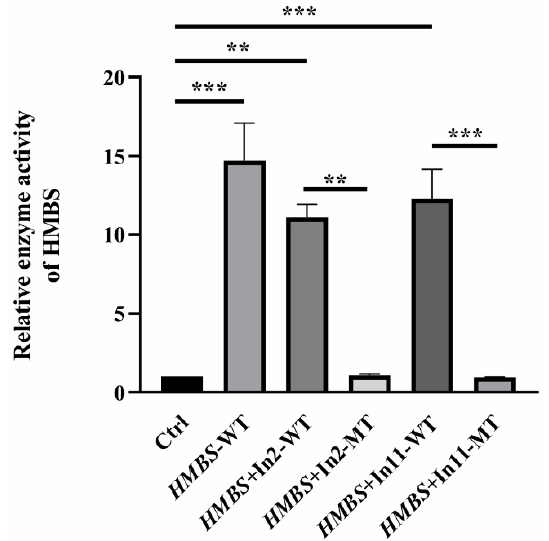
Figure 5. Enzyme activities of the HMBS mutants. The result of enzyme activity assay from HEK293T cells transfected with HMBS -WT, HMBS +In2-WT, HMBS +In2-MT, HMBS +In11-WT or HMBS +In11-MT plasmids. Data were presented as the mean ± SD from three independent experi- ments; *** p < 0.001; ** p < 0.01.